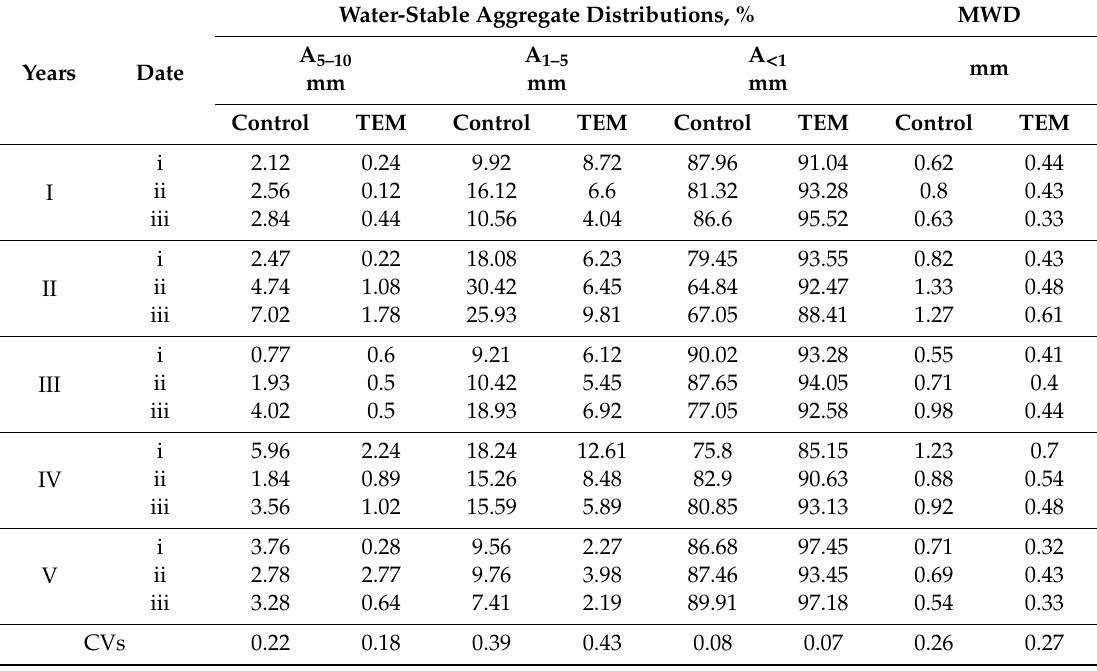
Table 5. Mean values of the water-stable aggregate content (A 5–10 , A 1–5 , and A < 1 ) and mean weight diameters (MWDs) on sampling